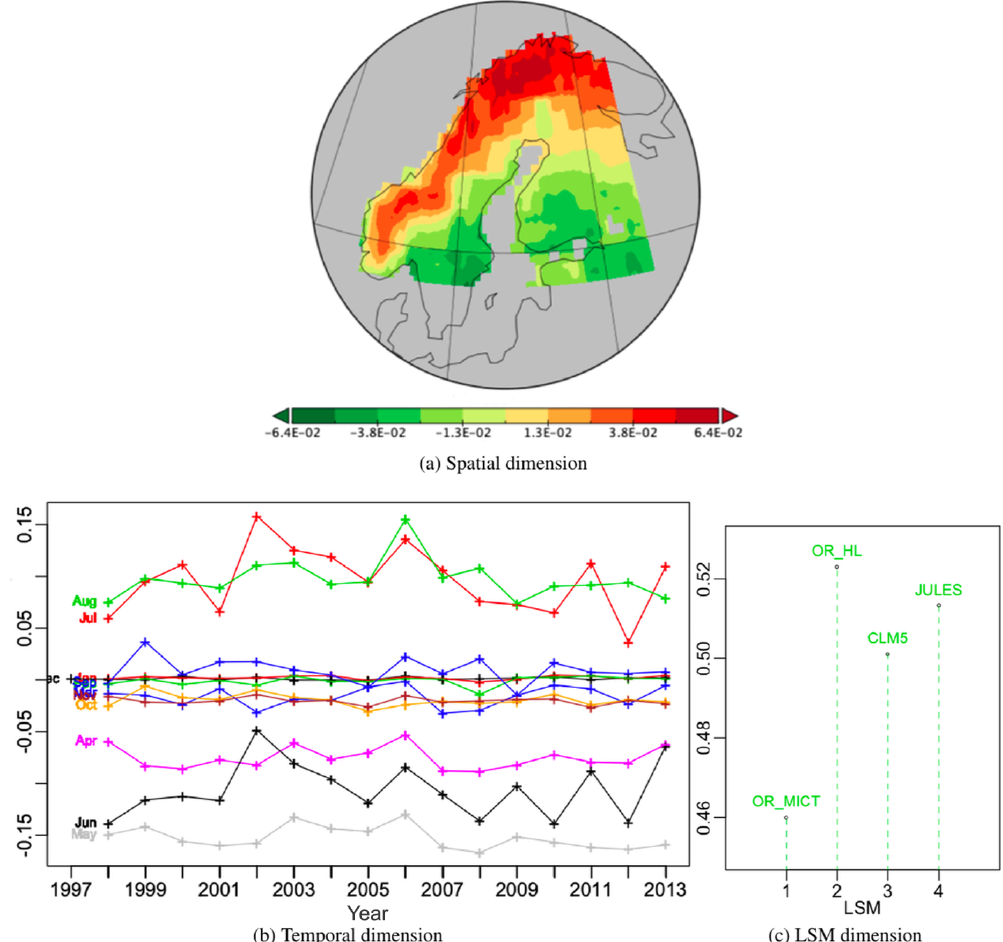
Figure 6. Plots for PT -no-9 associated with PT -no-1 along the LSM dimension, which is therefore identical to Fig. 3c; it represents 1.38% of the variability.